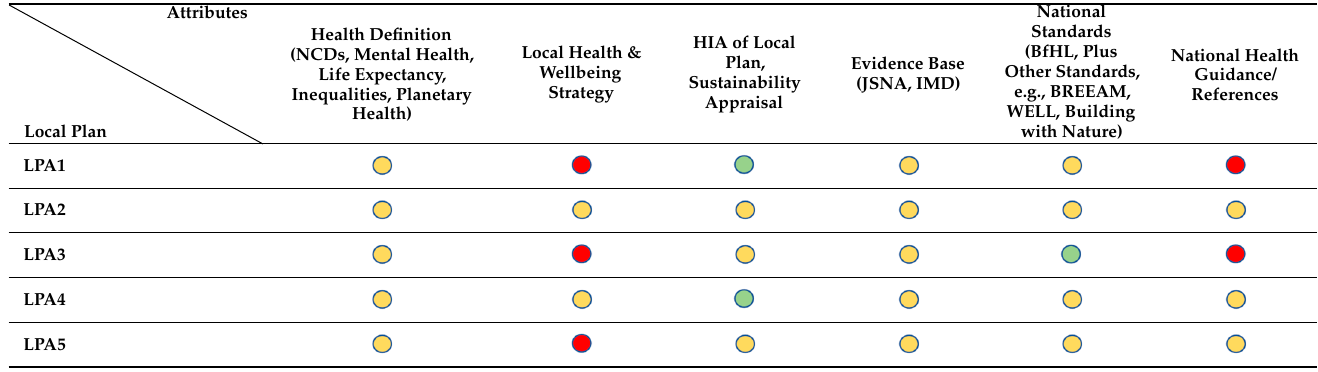
Table 3. Local plans and health requirements for developers.